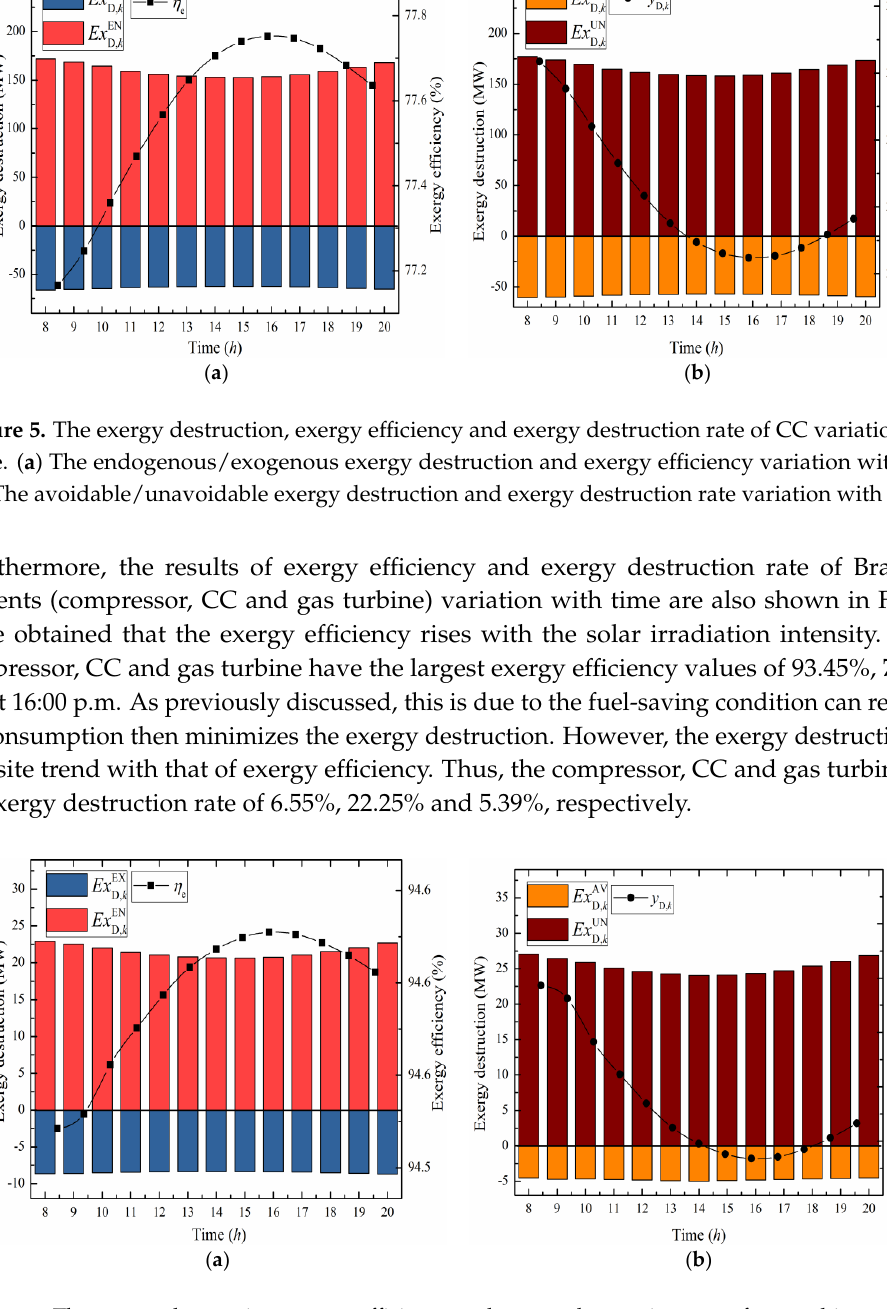
Figure 6. The exergy destruction, exergy efficiency and exergy destruction rate of gas turbine variation with time. ( a ) The endogenous/exogenous exergy destruction and exergy efficiency variation with time. ( b ) The avoidable/unavoidable exergy destruction and exergy destruction rate variation with